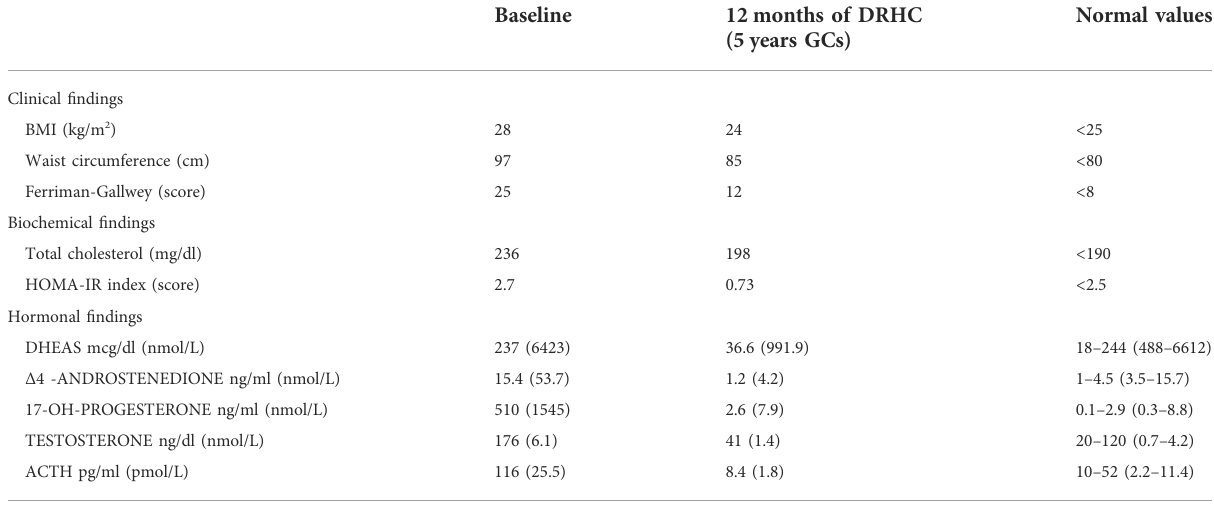
TABLE 1 Clinical, biochemical, and hormonal relevant fi ndings at diagnosis and after 12 months of dual-release hydrocortisone treatment (5 years of GCs).